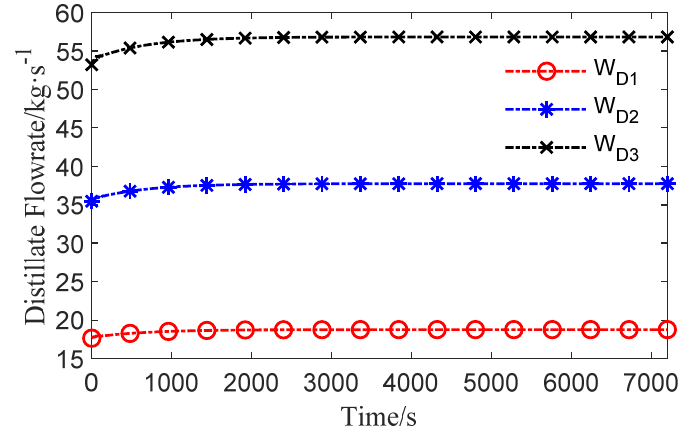
Figure 6. dynamic response with time. Figure 6. T B 1 , T B 2 , T B 3 dynamic response with time.